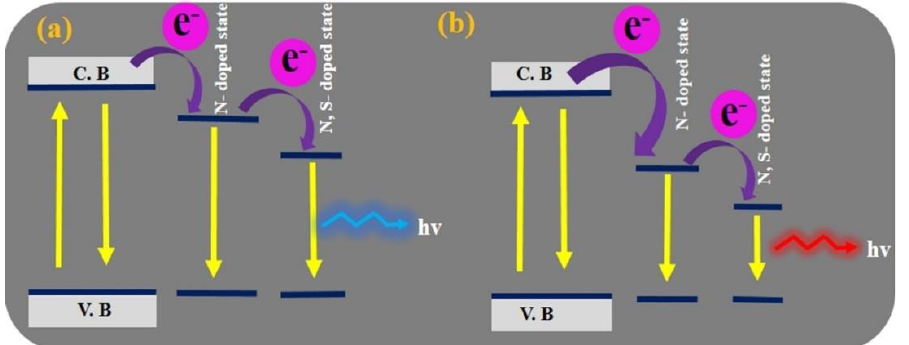
In N-doped CDs, the presence of C=S bonds, together with C=N bonds, are responsible for a red shift in the emission, as illustrated in Figure 11.